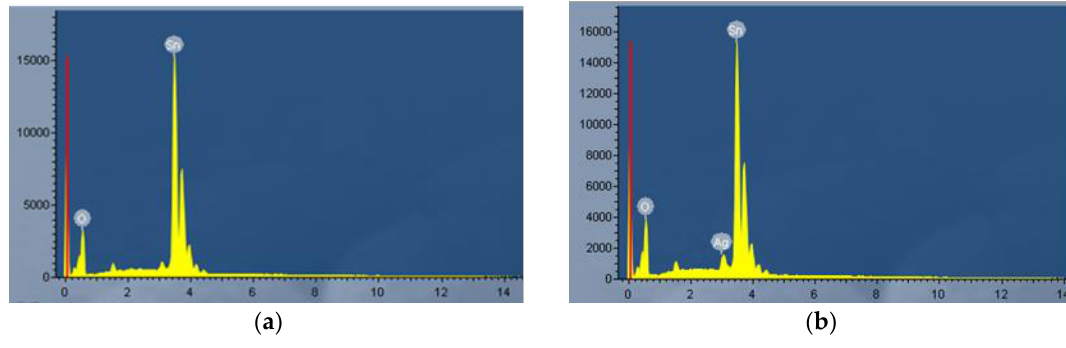
Figure 4. EDS spectra of ( a ) pure ( b ) 3 at.% Ag-doped SnO 2 nanospheres.